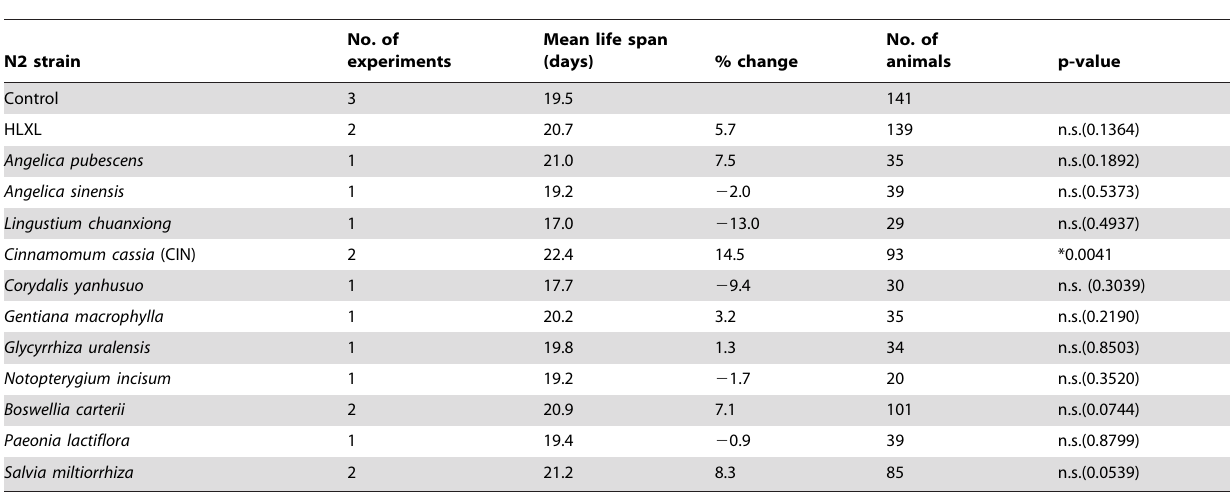
Table 4. Life span assays in wild type C. elegans fed with HLXL and individual herbs.